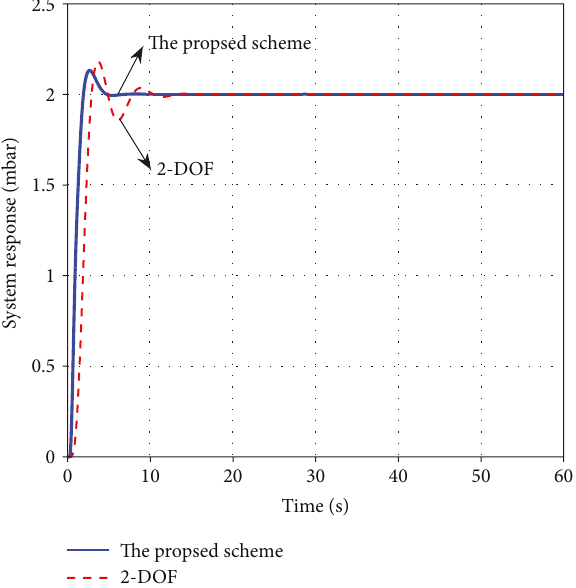
Figure 10: System response comparison without disturbance.